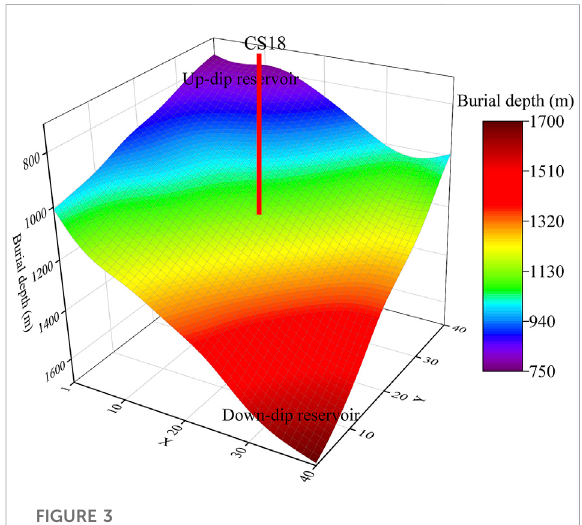
FIGURE 4 Ideal steeply inclined model (ISIM).